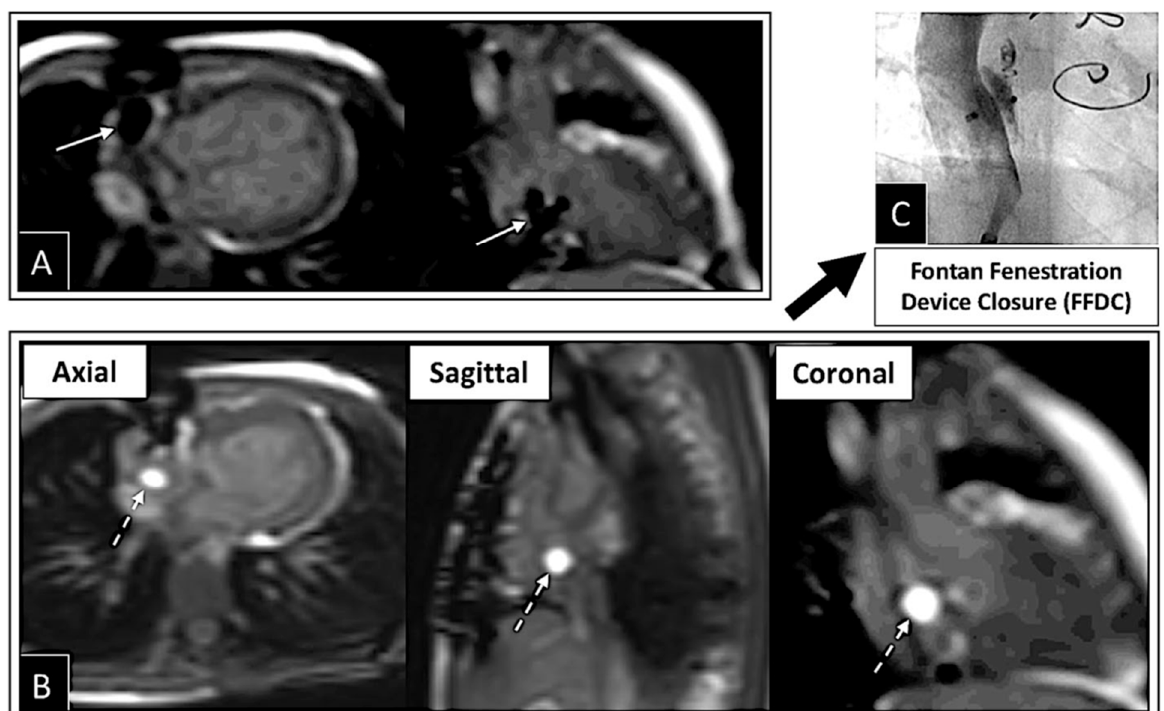
Figure 25. Series of images demonstrating iCMR Fontan fenestration test occlusion (FFTO) leading to device closure in the fluoroscopy lab. ( A ) iCMR guidance as the MR-conditional wire crosses the Fontan fenestration. Wire position is confirmed in multiple planes. ( B ) Multiple planes demonstrating FFTO to test eligibility for device closure. ( C ) Patient was deemed appropriate and transferred to the fluoroscopy X-ray suite where Fontan fenestration device closure (FFDC) was performed. Revised from ref [16].